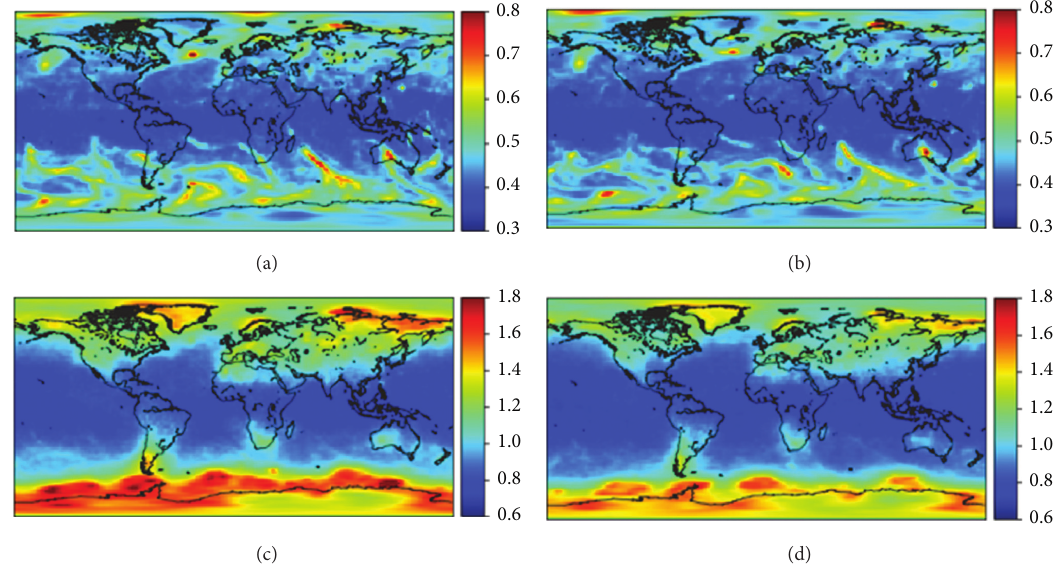
Figure 4: Temperature standard deviation field at 500hPa (a) at 1200 UTC, (b) at 2400 UTC, and (c) and (d) as the former but at